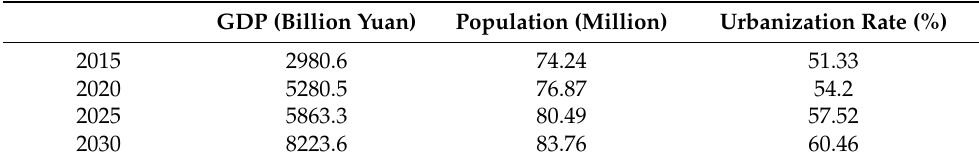
Table 3. The predicted GDP, population, and urbanization rate in Hebei Province for the period